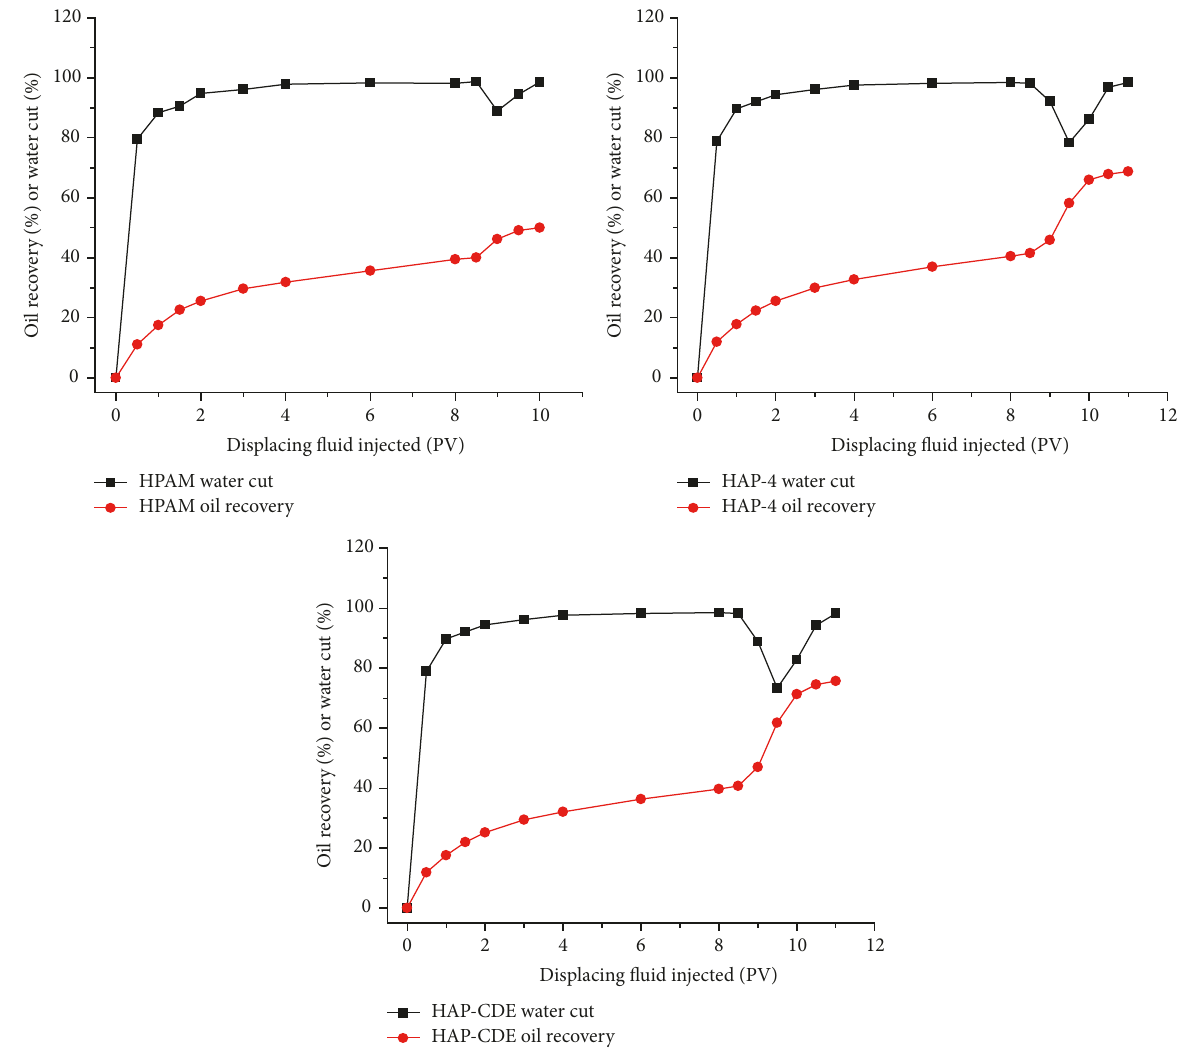
Figure 8: Oil recovery and water cut as a function of PV (0.2